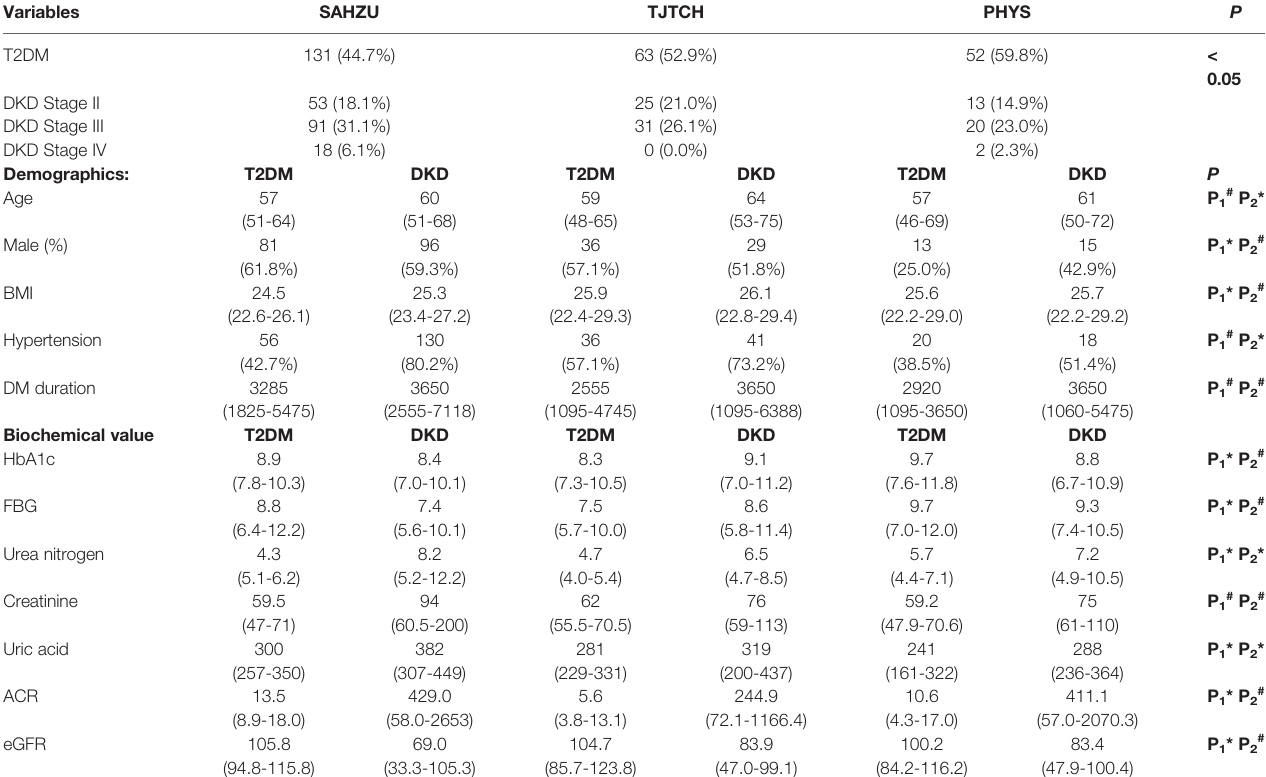
TABLE 1 | The Basic Characteristics of Study Patients in Three Medical Centers. SAHZU.